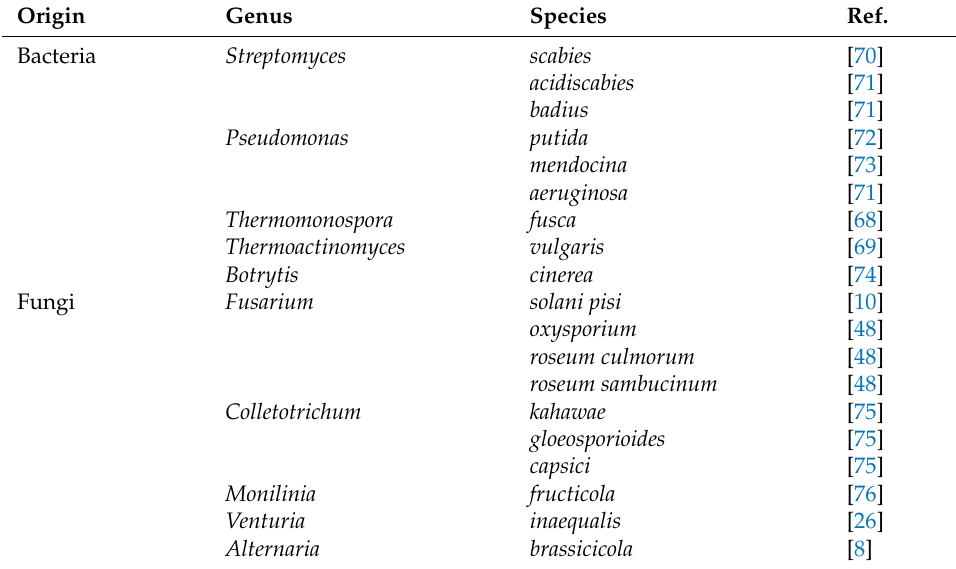
Table 4. Cutinases producing